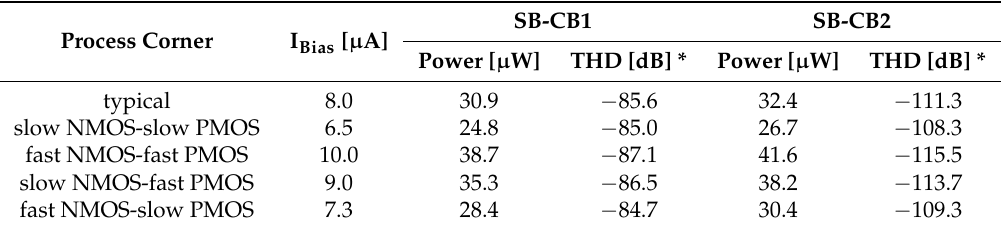
Table 3. THD and static power considering process variations.